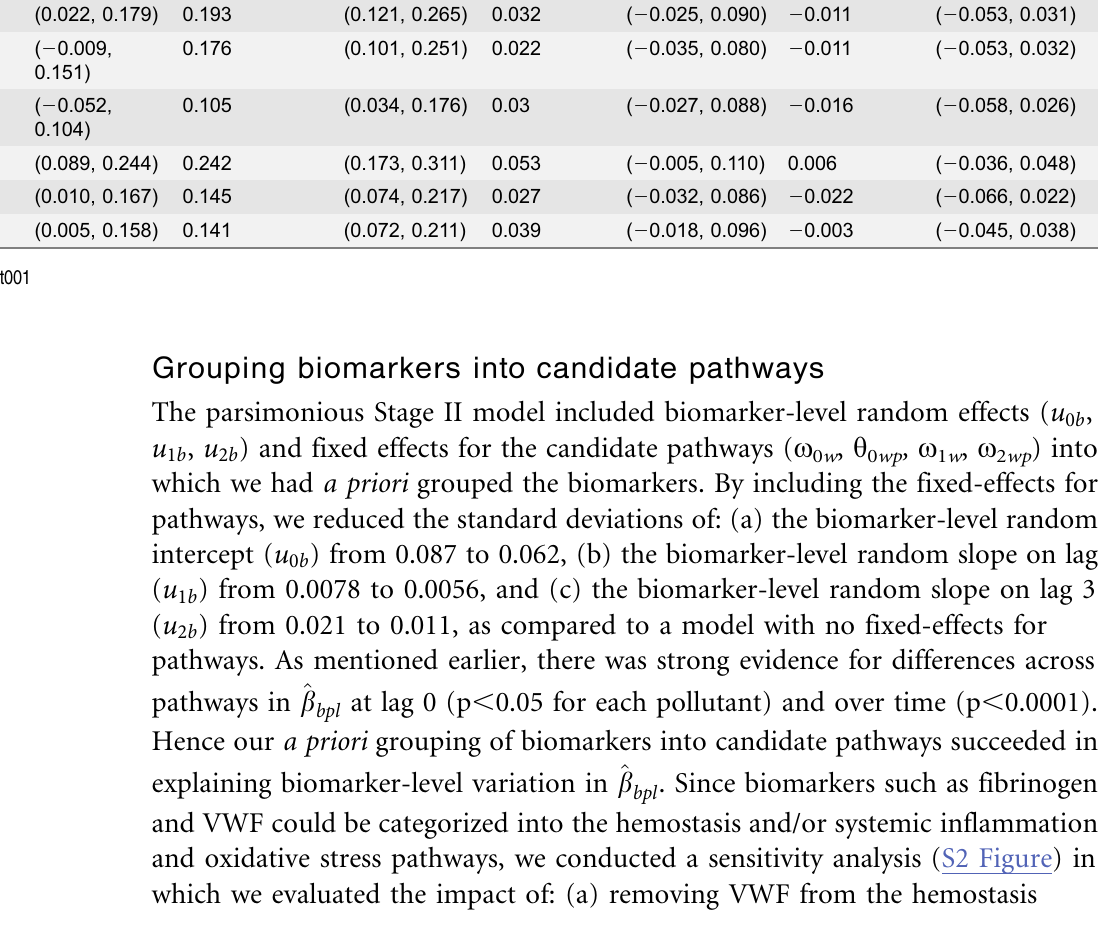
Table 2. For sulfate, rate of change per lag day in the mean association ( ^ b ) between standardized 24 hour average ambient sulfate concentrations and the bpl average, standardized biomarker in each pathway. Before lag 3 After lag 3 Estimates* (95% CI)